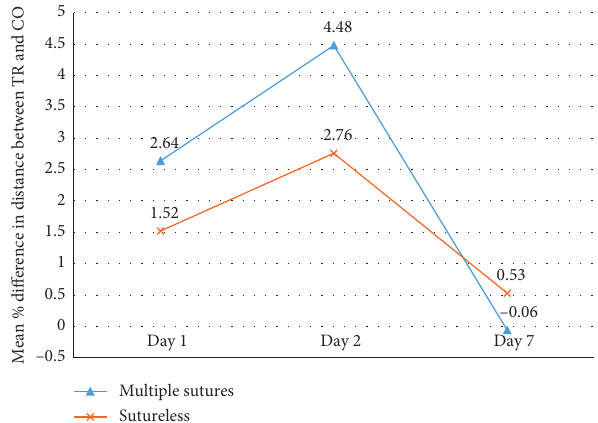
Figure 3: Comparison of swelling (tragus to commissure of lips) between group 1 (multiple sutures) and group 2 (sutureless) on patients undergoing third molar surgery.